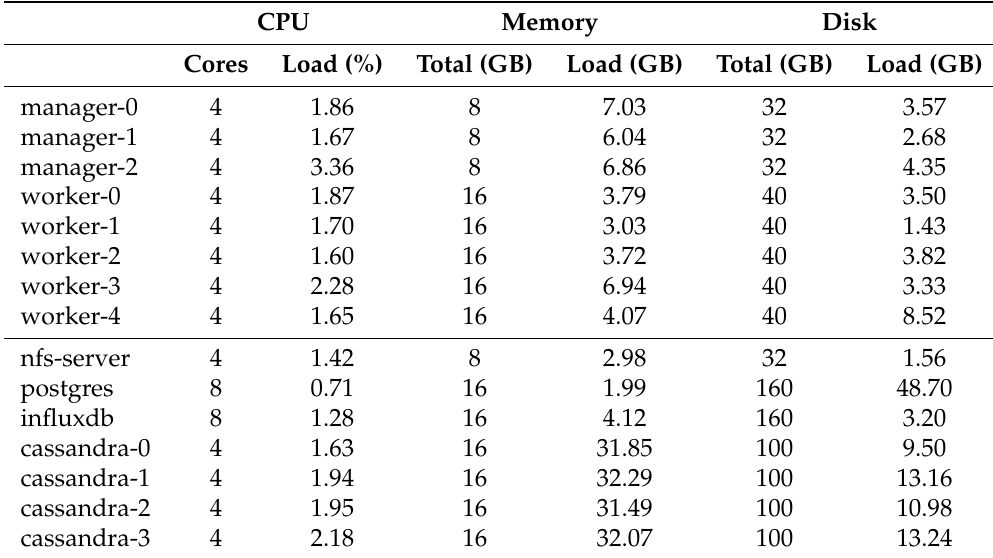
Table 6. Specifications and loads of the servers used to deploy our platform.